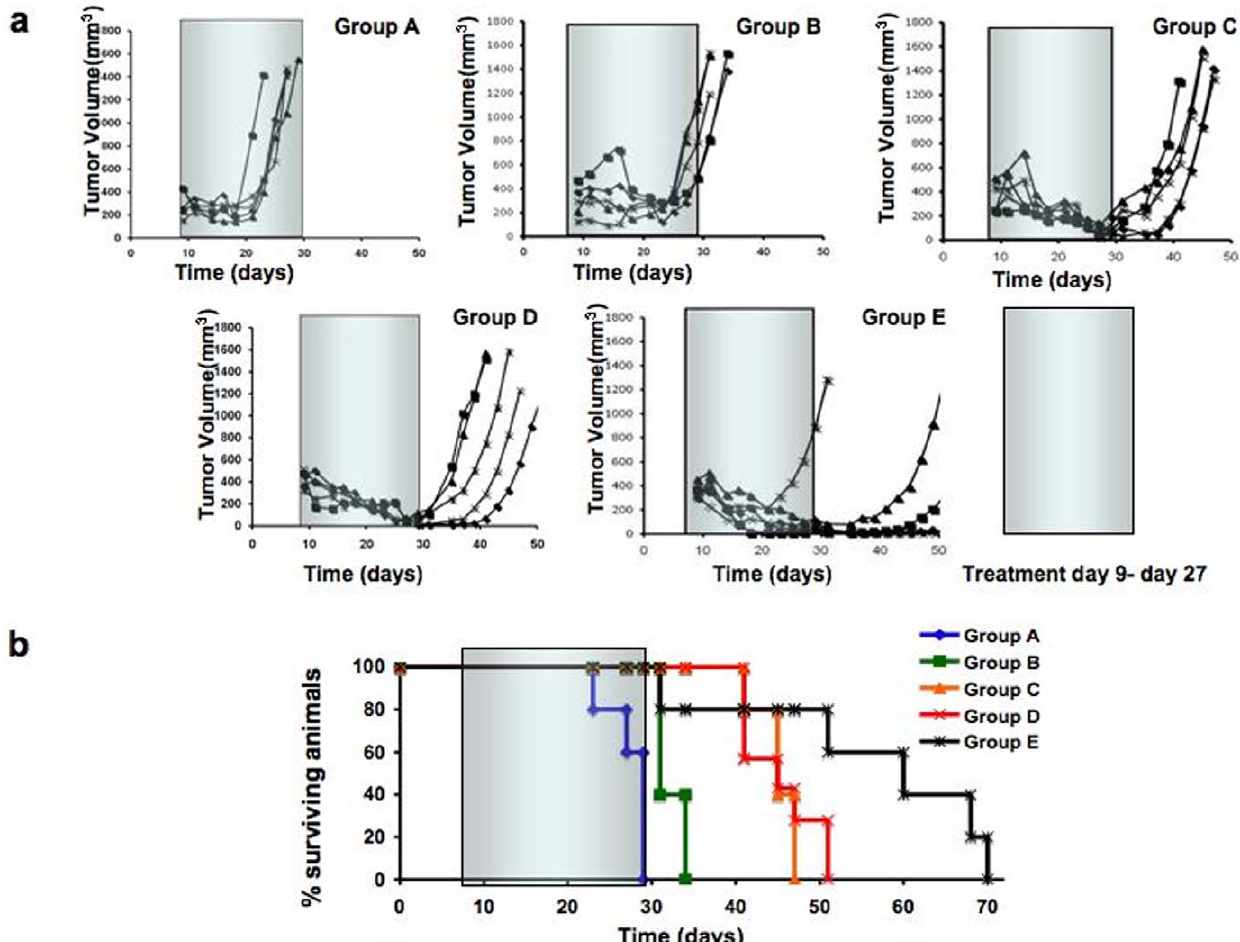
Figure 7. Treatment of tumor-bearing mice with 2DG-ABT combination. Five million PPC-1 human prostate cancer cells were xenografted onto nude mice as described in the text and the method. a, Mice Tumor volumes were measured in mice (n=7 per group) treated with diluent only (group A), 2DG (group B), ABT-263 (group C), 2DG plus ABT-263 (group D), or 2DG mixed with D-glucose plus ABT-263 (group E), as explained in the text, where drugs were administered 3 times weekly between day 9 and 27 (gray rectangles). b, Survival of tumor-bearing mice was determined at various times post-inoculation with PPC-1 cells. The % of surviving mice is indicated from groups A-E (n=7 per group). The difference of survival days between Group C & D versus Group E is p=0.0283, 95% confidence interval of this difference: from 2 20.98 to 2 1.36 by unpaired t-test.